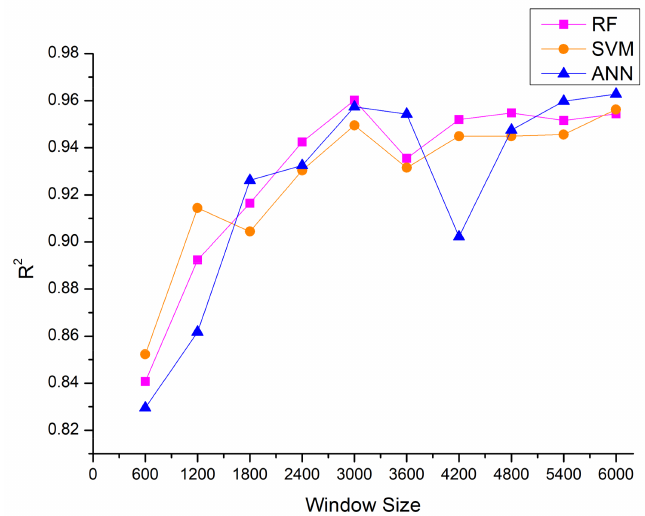
Figure 10. Performance evaluation on different window sizes for